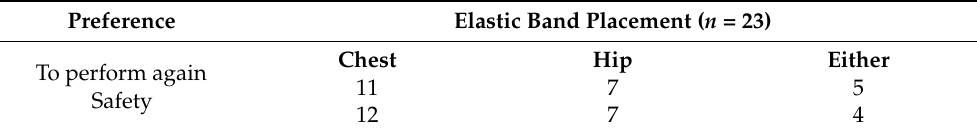
Table 9. Participants’ preferences for the location of the elastic band. Preference To perform